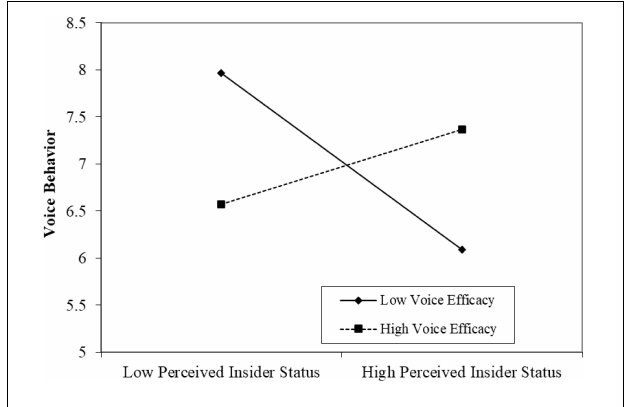
FIGURE 2 | Moderating effect of voice efficacy.